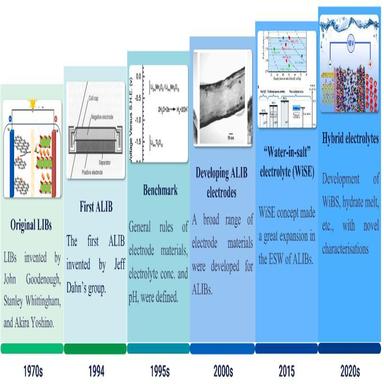
Historical development of aqueous lithium batteries, Reproduced with permissions from American Association for the Advancement of Science, IOP Science, MDPI and Cell press.